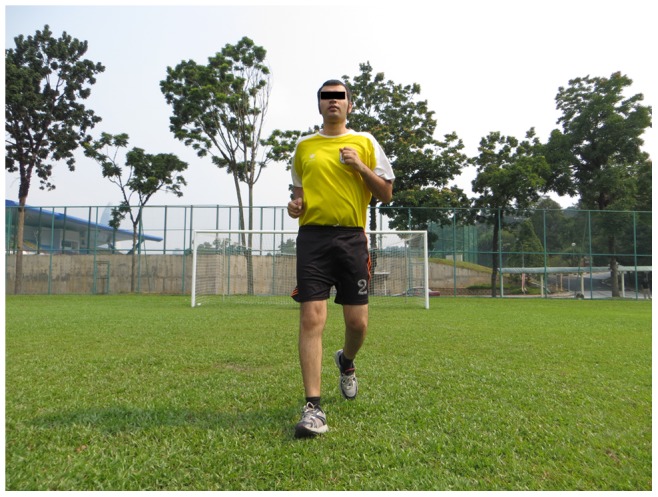
Running straight ahead.